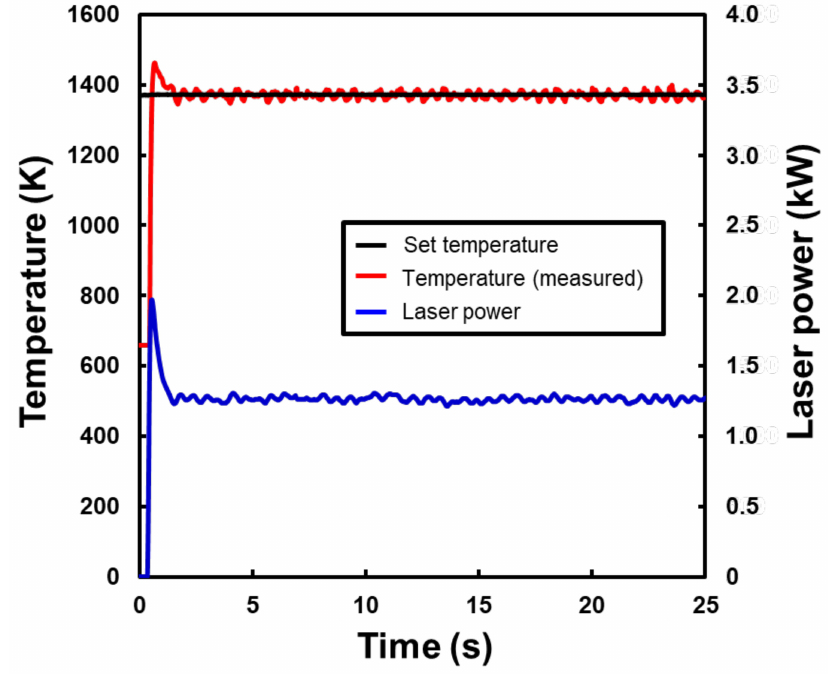
Figure 5. Typical laser power and temperature history during laser-assisted heat treatment at target temperatures of 1373 K for P20-improved